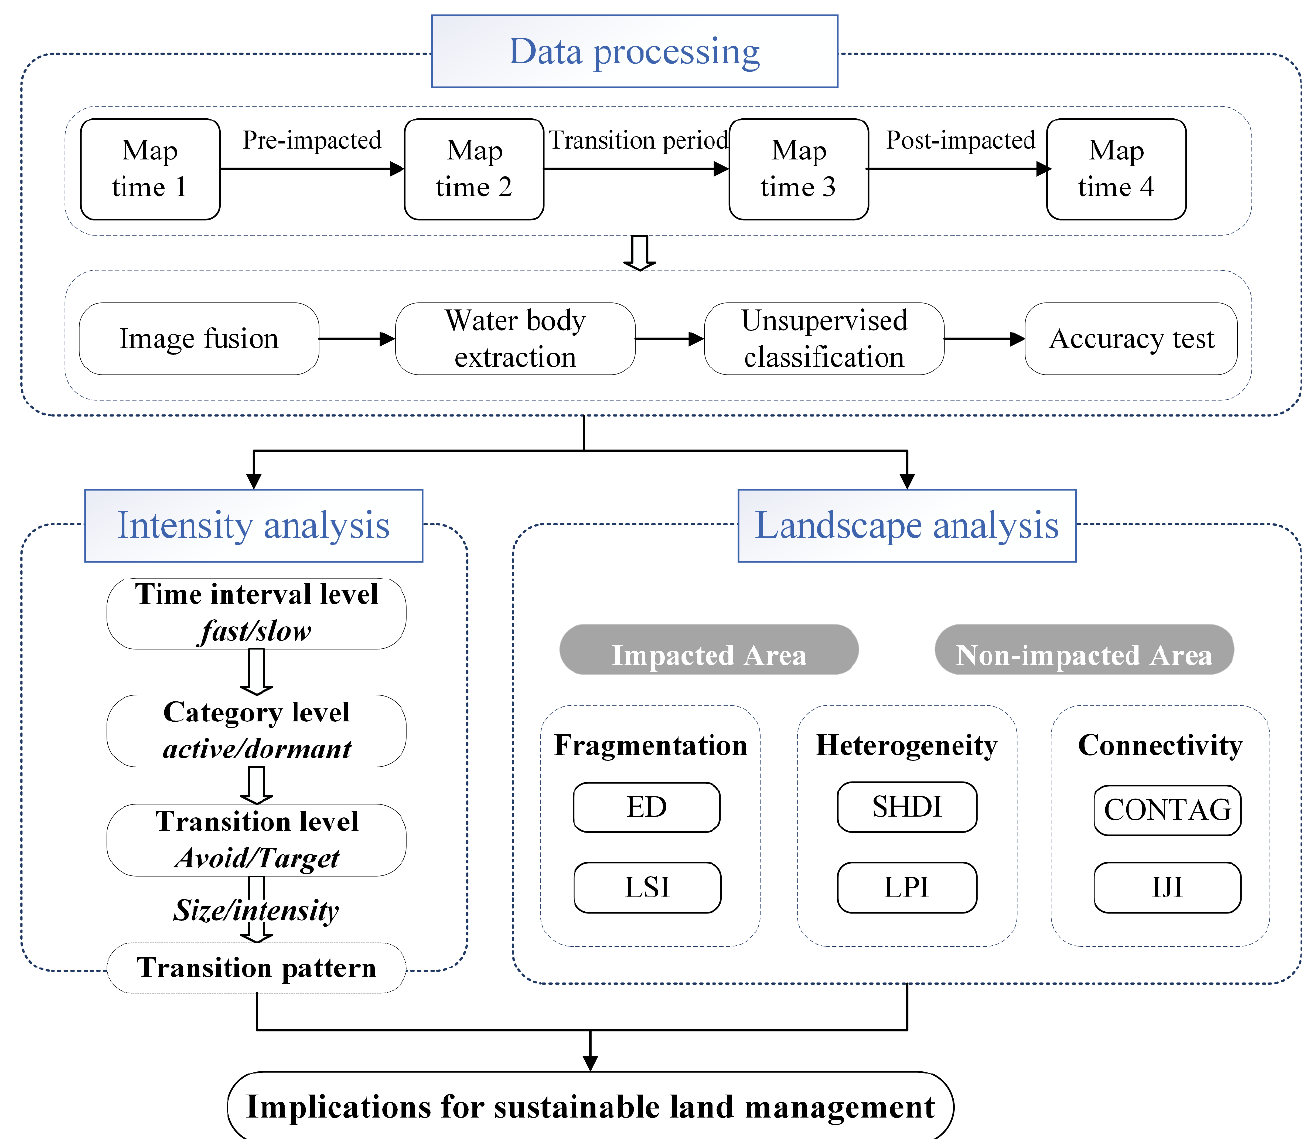
Figure 2. Methodological road map.